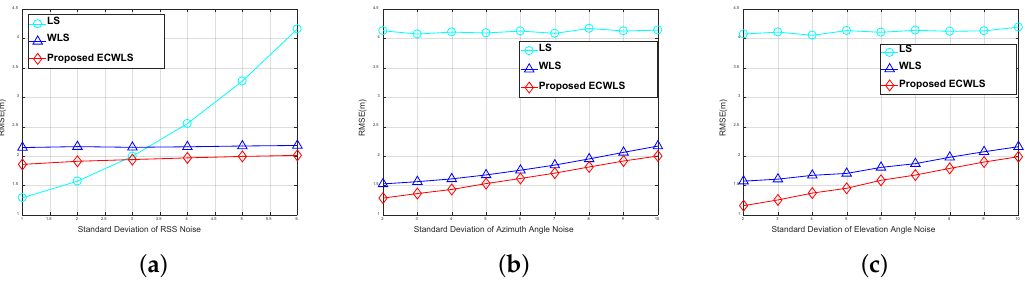
Figure 5. ( a ) RMSE vs. standard deviation of received signal strength (RSS) noise; ( b ) RMSE vs. standard deviation of azimuth angle noise; ( c ) RMSE vs. standard deviation of elevation angle noise.